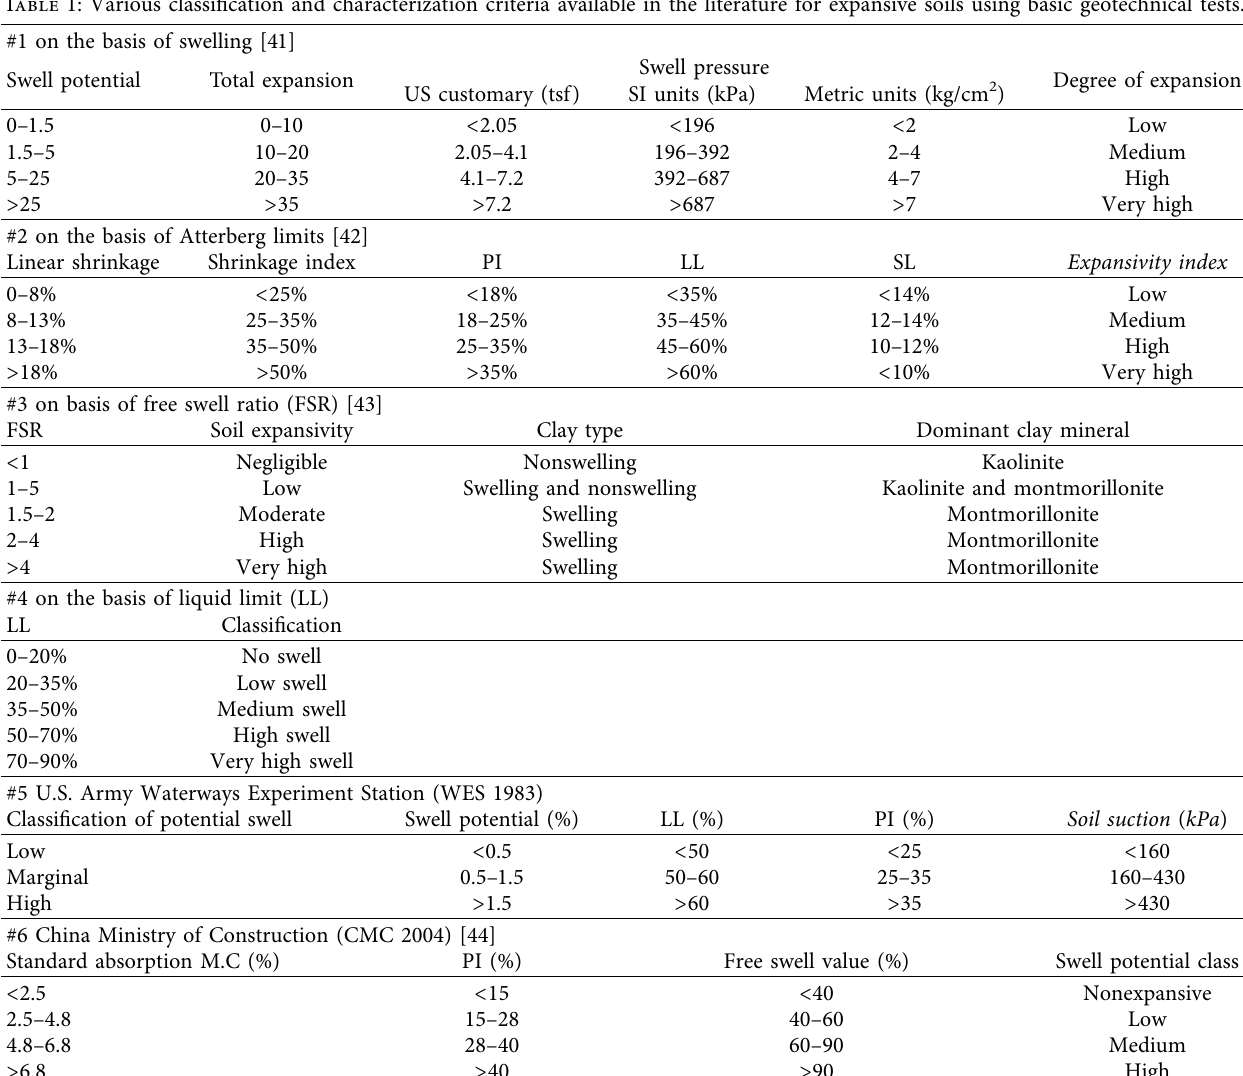
Table 1: Various classification and characterization criteria available in the literature for expansive soils using basic geotechnical tests.